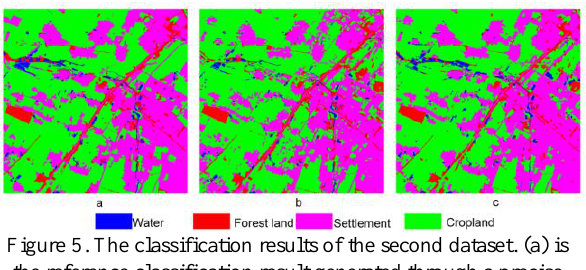
Figure 4. The ALOS and TM original image of the second dataset. (a) is original image of ALOS panchromatic band, (b) is the synthetic image of ALOS multispectral 342 bands, and (c) is the synthetic image of TM 543 multispectral bands.